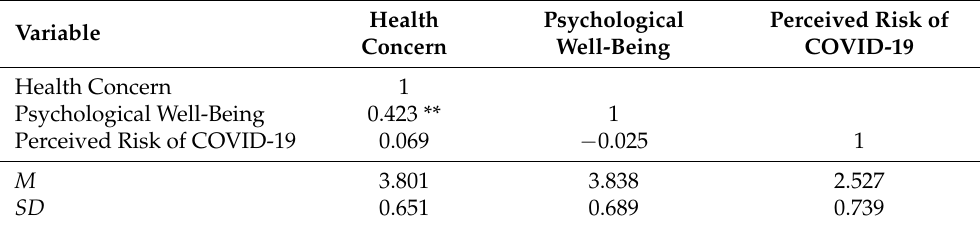
Table 5. Correlation coefficients between variables.